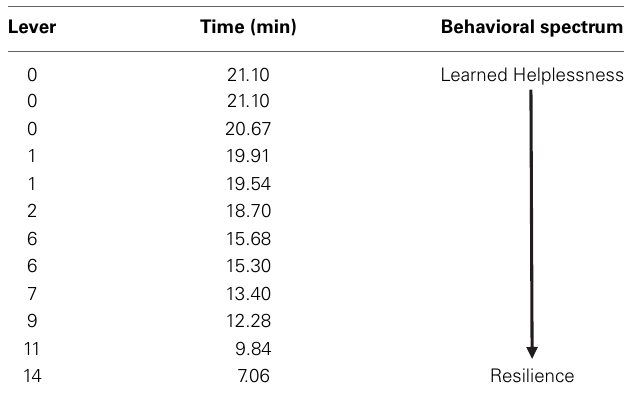
Table 1 | Distribution of escape behavior.